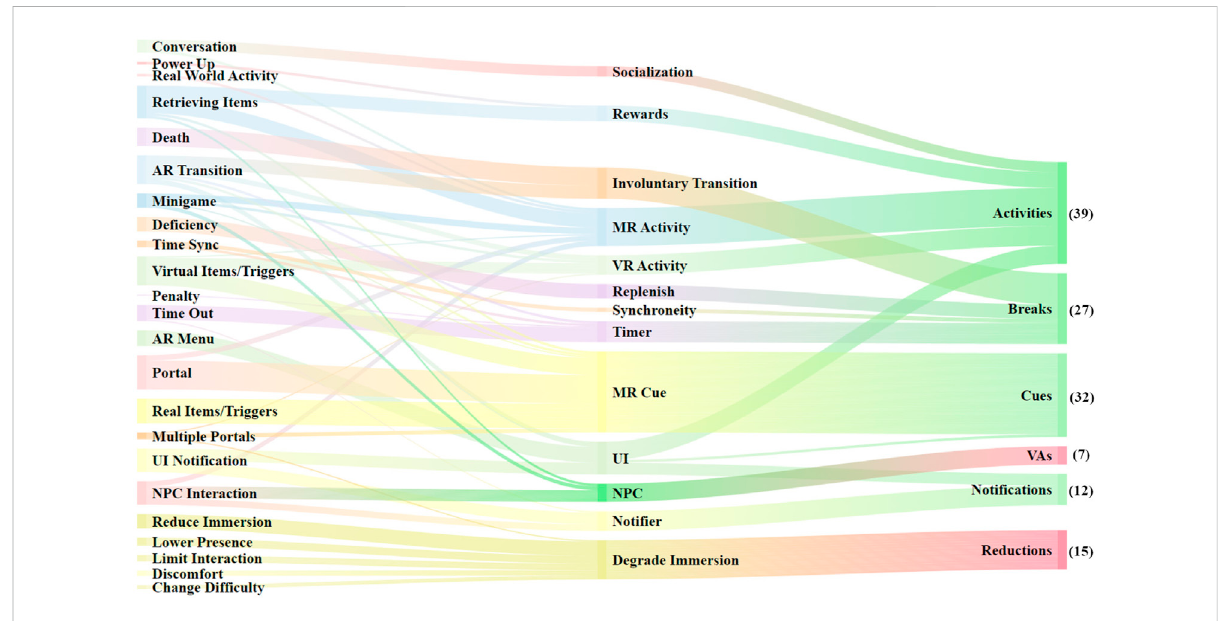
FIGURE 2 Classi fi cations of the elicited techniques that led to the six